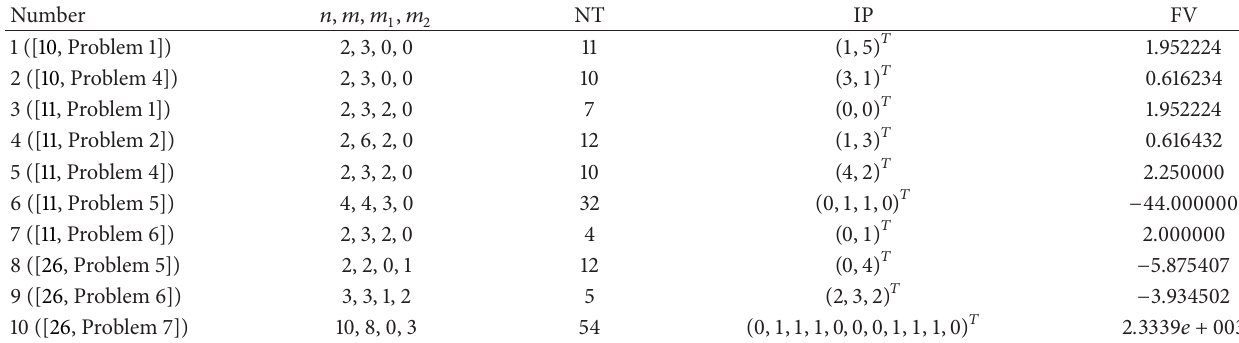
Table 1: Numerical results of Algorithm